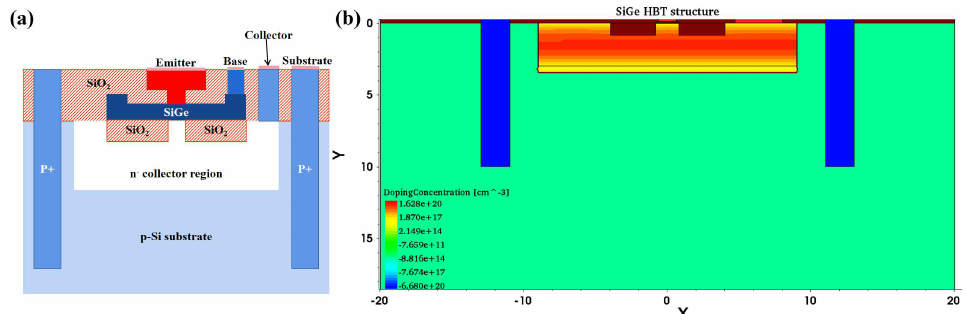
Figure 1. Schematic diagram ( a ) and the internal structure simulation profile ( b ) of the SiGe HBT.